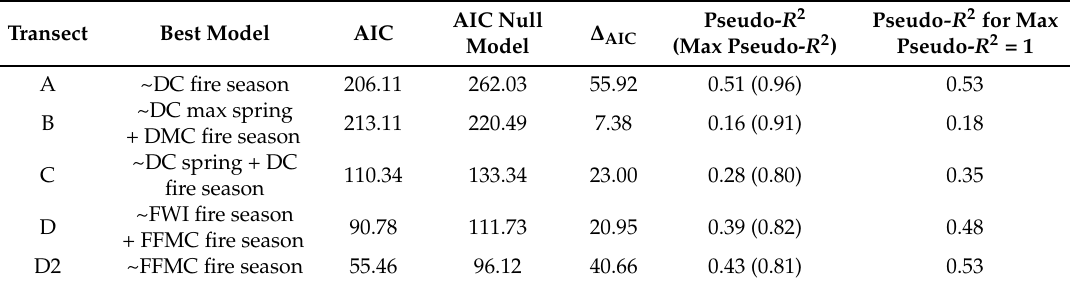
Table 1. Best models according to the supervised forward model selection procedure for each transect. AIC of the best and null models are given as well as their difference ( ∆ AIC ). Cox and Snell’s pseudo- R 2 of best models, their associated maximum value, and the corresponding pseudo -R 2 value for max pseudo -R 2 = 1 are also shown.